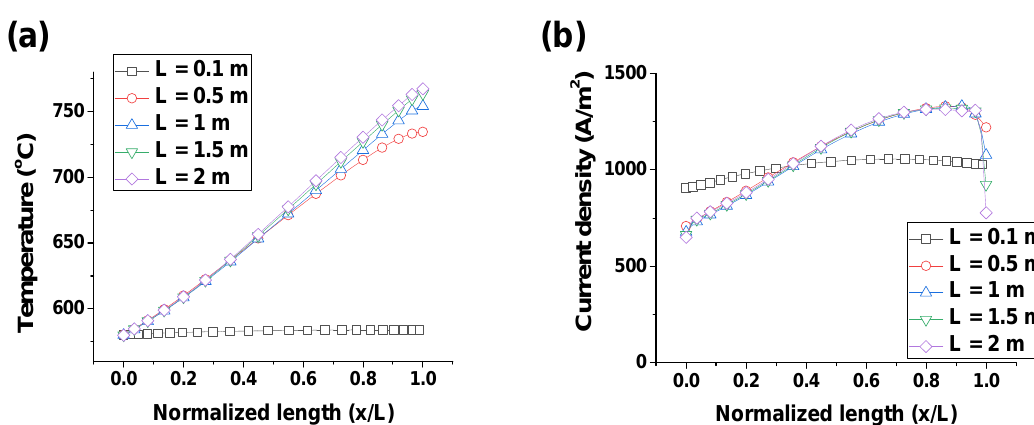
Figure 10. ( a ) Normalized temperature and ( b ) current density distribution relative to the length for the cross ‐ flow type.